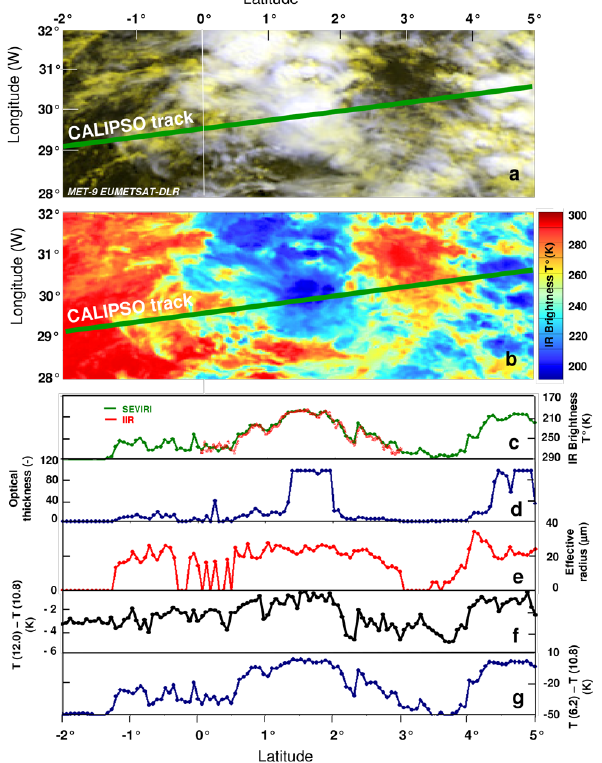
Fig. 4. As Fig. 1, but for the cloud system of 20 June 2008 (15:43 UTC). Shaded areas indicate the active parts (A and B) of the MCS. The effective radius retrieved from SEVIRI data are superimposed on the curve in (c)